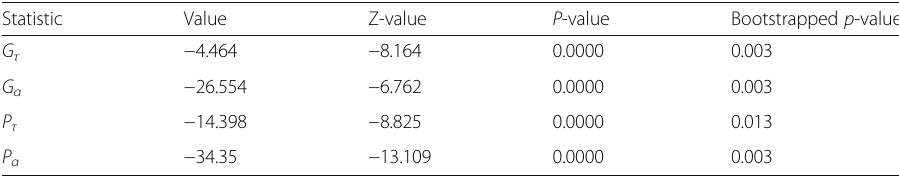
Table 3 Panel Bootstrap Cointegration Test Statistic Value